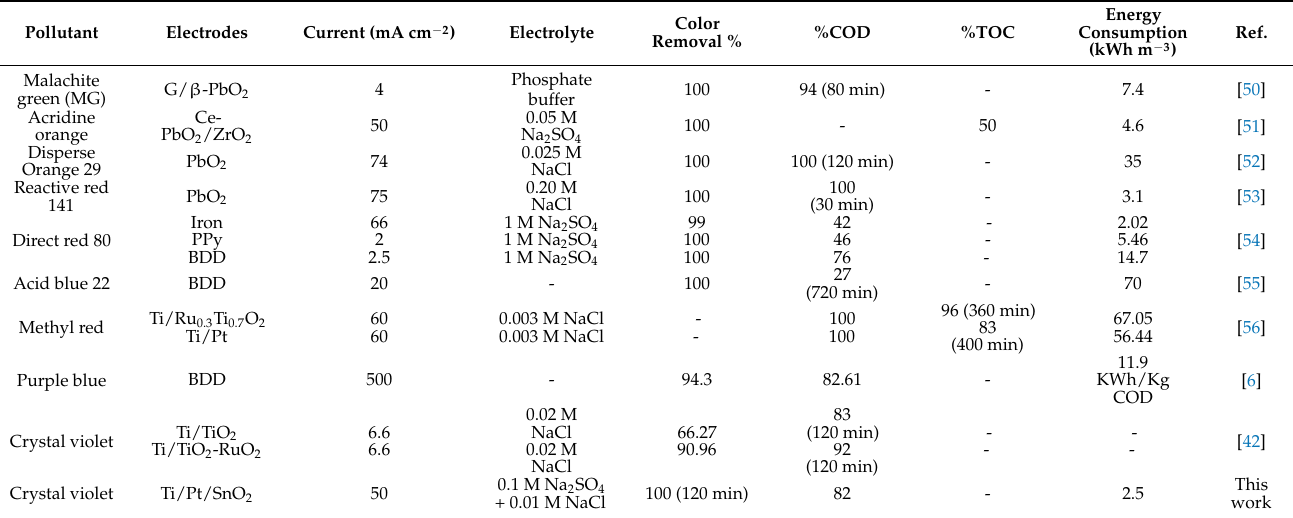
Table 3. Degradation of different dyes by anodic